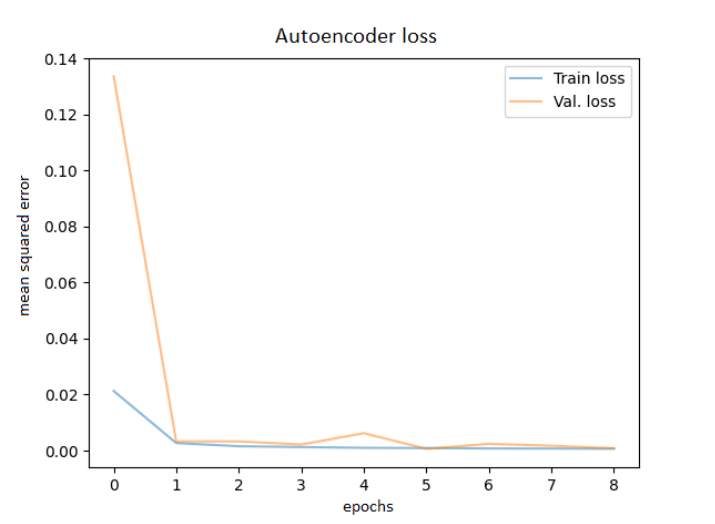
Figure 7. Autoencoder training and validation